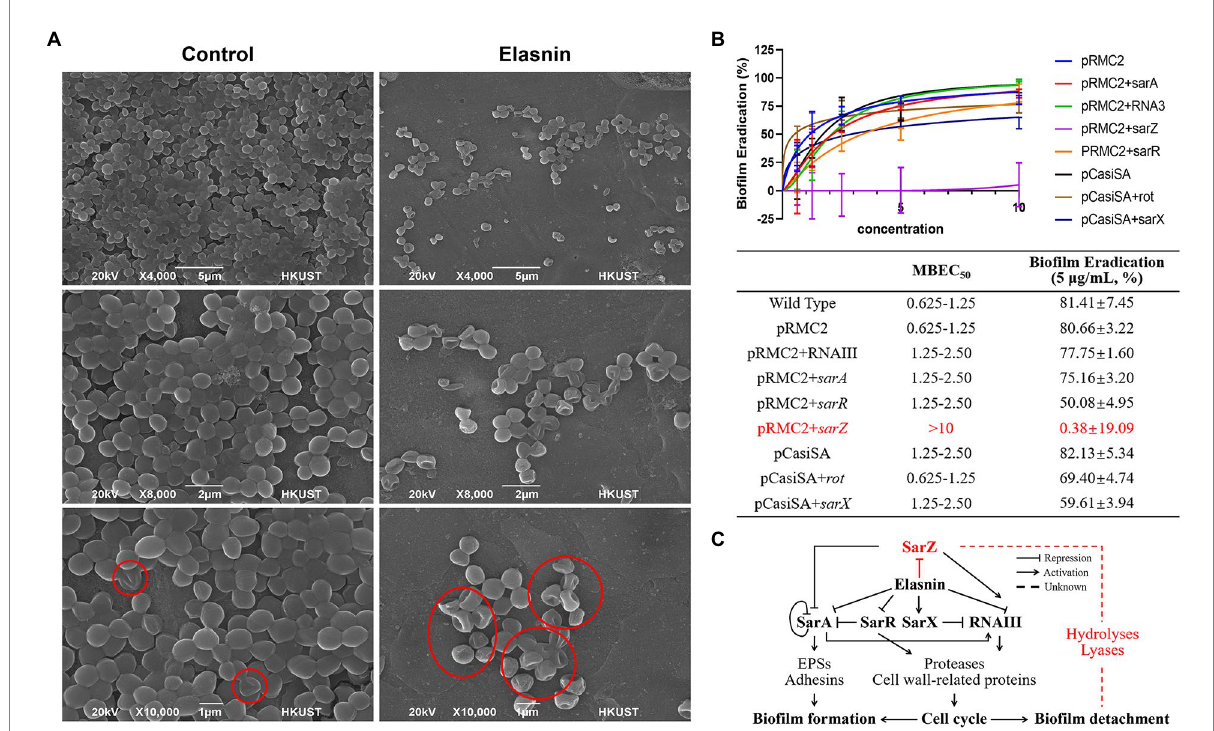
FIGURE 7 Validation of the proposed mode of action of elasnin. (A) Scanning electron microscopy observation of untreated and elasnin-treated (5 μ g/ml) biofilm cells, illustrating the large amount of defective cells within elasnin-treated biofilms. Regions marked with red outlines indicate cells with cell wall defect. (B) MBEC and biofilm-eradication efficacy of elasnin (5 μ g/ml) against transcription-inhibited and overexpressed strains ( n = 9, average ± standard deviation). The expression of overexpressed genes was induced by 0.2 μ g/ml anhydrotetracycline. (C) Schematic of